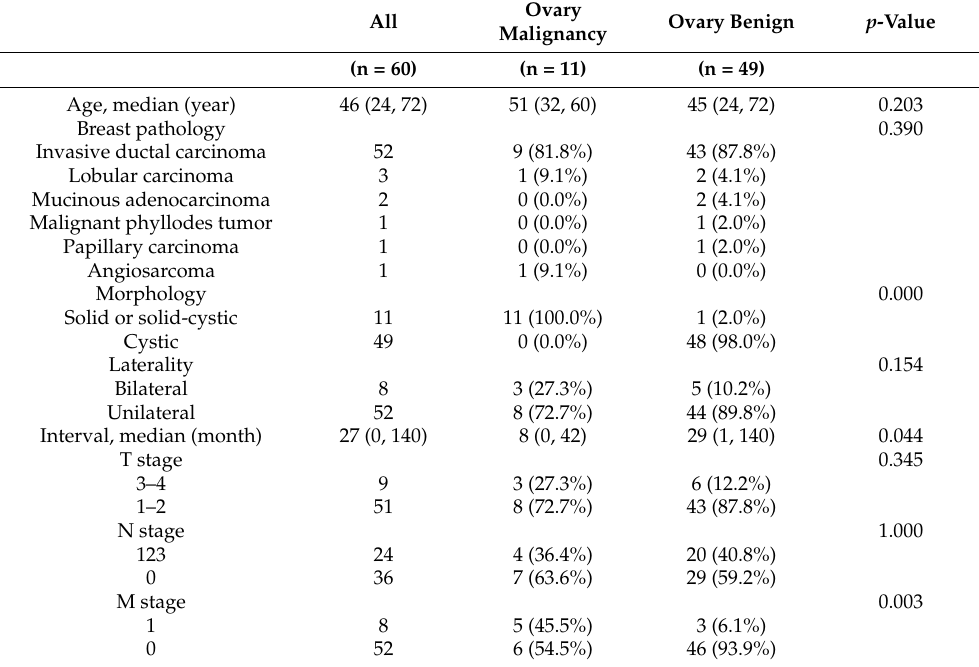
Figure 1. Flow diagram of the study cohort. Table 1. Demographics of patients with prior breast cancer having incidental ovarian tumors.